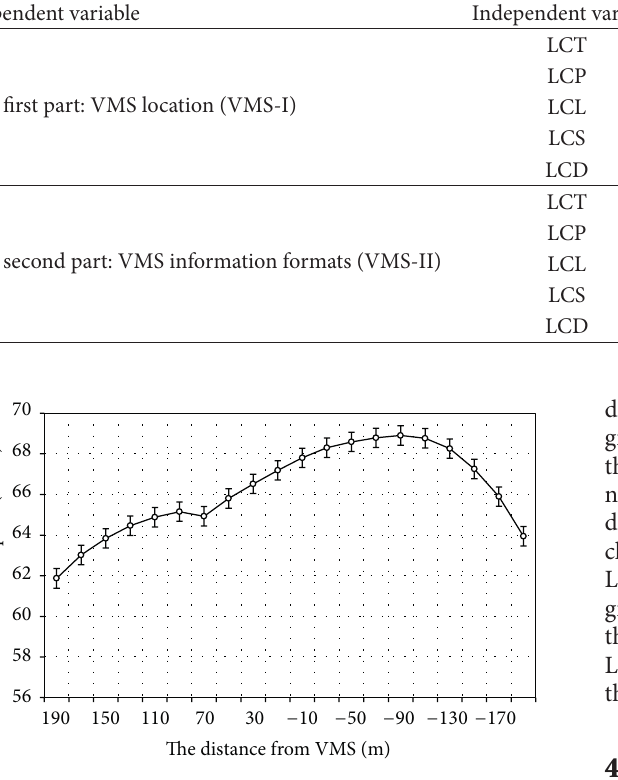
Figure 5: The trend of average velocities before and after VMS-I.